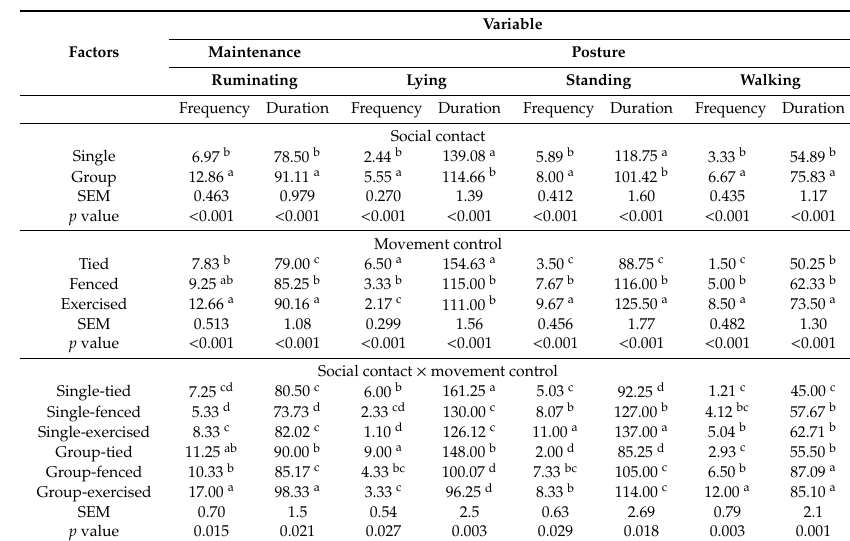
Table 2. E ff ects of social contact, movement control and their interaction on frequency (n / 20 min) and duration (sec / 20 min) of maintenance and posture behaviors of male dromedaries during the rutting